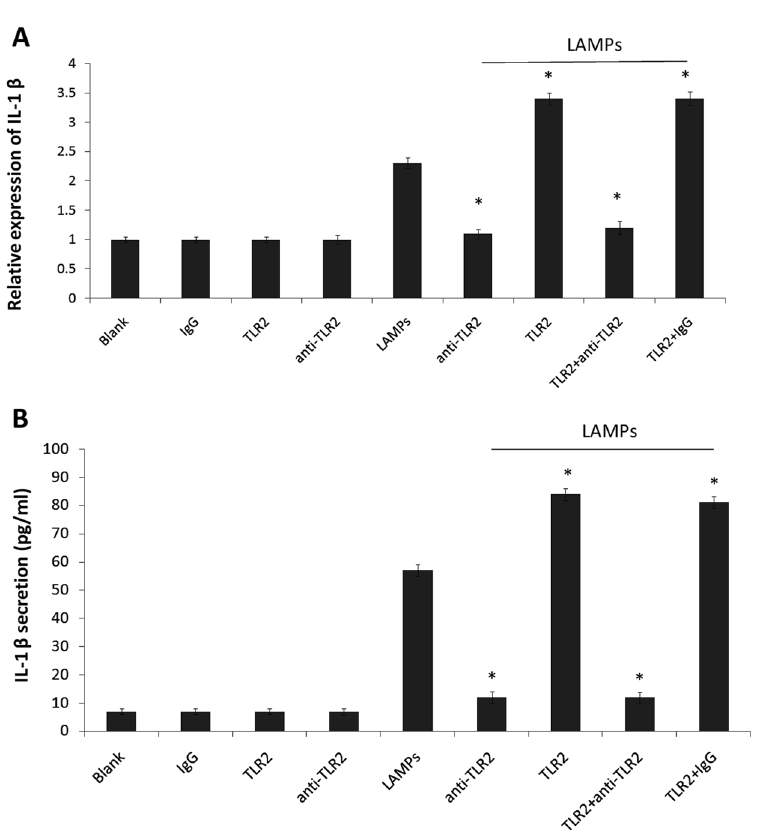
Figure 4. TLR2 is required for LAMP-induced IL-1 β expression. EBL cells were transiently transfected with 0.2 μ g/mL pHA-TLR2. After 24 h, the cells were pre-treated with 10 μ g/mL human IgG or anti-TLR2 mAb (IgG) for 30 min and then stimulated with or without 1.0 μ g/mL LAMPs. After 6 h, cells and supernatants were respectively harvested and analyzed by ( A ) real-time PCR and ( B ) ELISA. Data are presented as the mean and standard deviation of three assays. * p < 0.05 compared with the LAMP-stimulated